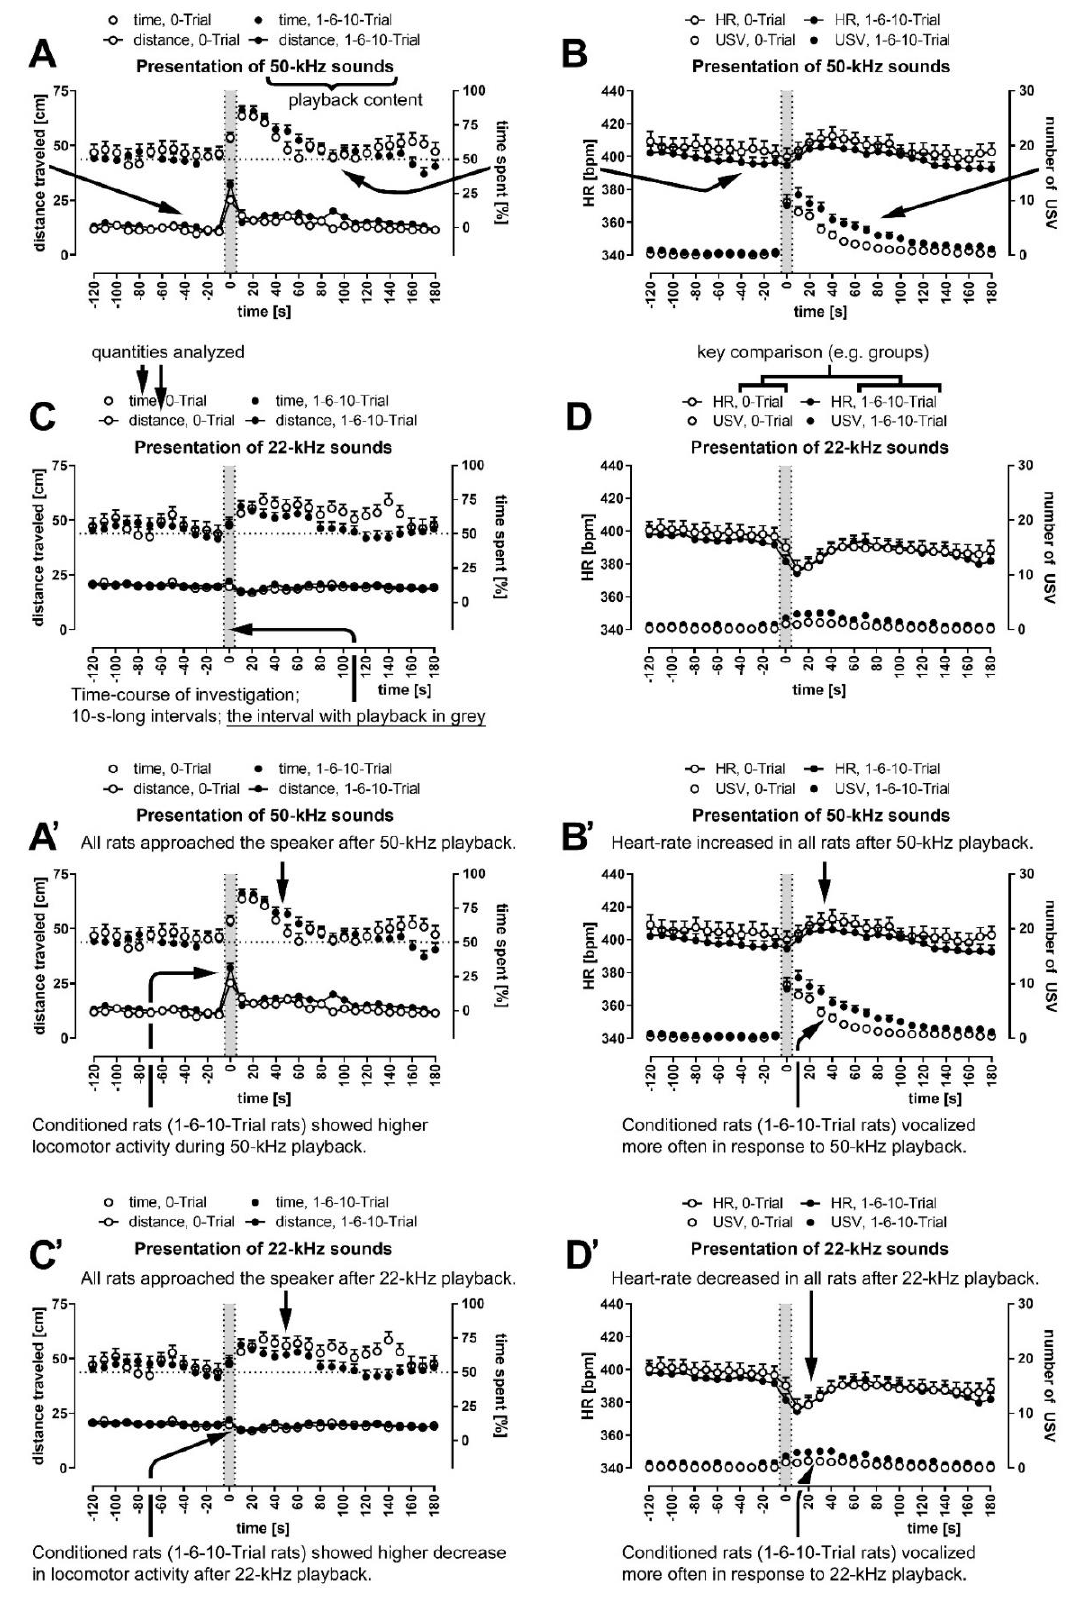
Figure 3. ( A – D ) Main results from Figure 2A,B,E,F with guiding explanations (arrows) pointing to measured quantities and crucial graph elements. ( A’ – D’ ) Main take-home messages in the form of short titles connected (arrows) with important data